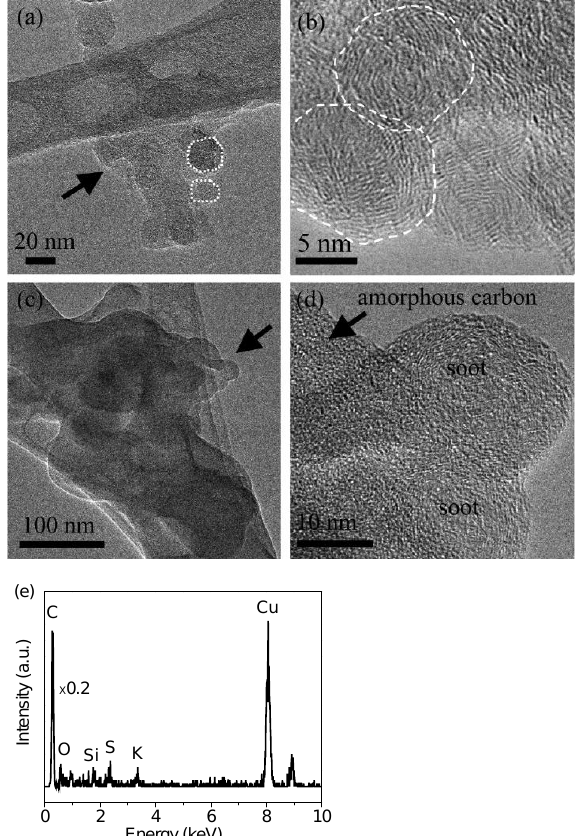
Figure 3. TEM images of samples collected at 450 m altitude, (a) soot of spherical2 Fig. 3. TEM images of samples collected at 450m altitude, (a) soot of spherical subparticles (spherules) and (b) their HRTEM image subparticles (spherules) and (b) their HRTEM image from the arrowed area, (c) soot of non-3 from the arrowed area, (c) soot of non-spherical subparticles and spherical subparticles and (d) their HRTEM image from the arrowed area. EDS results (e, f)4 (e) their HRTEM image from the arrowed area. EDS results (e, f) from the soot in image (a, c), respectively. The intensity of the both carbon peaks in (e) and5 from the soot in image (a, c) , respectively. The intensity of the both carbon peaks in (e) and (f) is multiplied by factor of 0.2 for com- (f) is multiplied by factor of 0.2 for comparison with the weak signals from other elements.6 parison with the weak signals from other